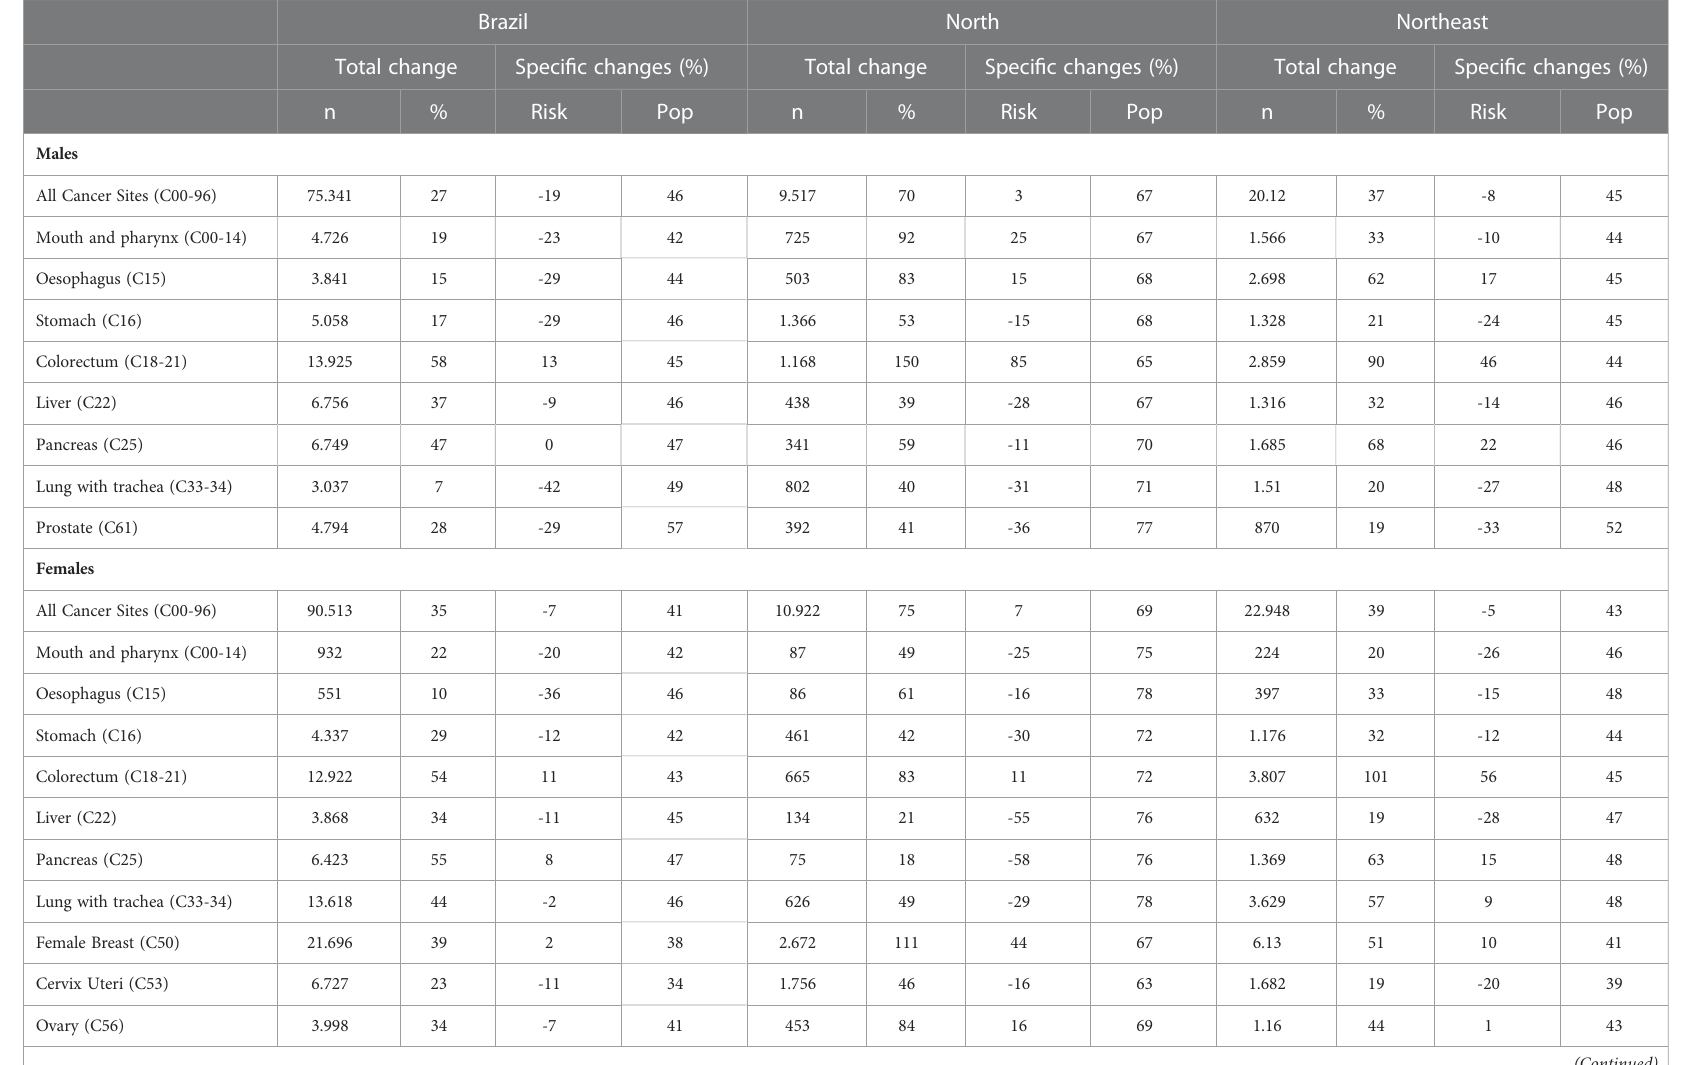
TABLE 2 Relative changes in number of deaths, total percentage of change and percentage attributed to speci fi c changes in risk factors (Risk) and population (Pop), comparison between the last predicted (2026-2030) and the last observed period (2011-2015). Brazil North